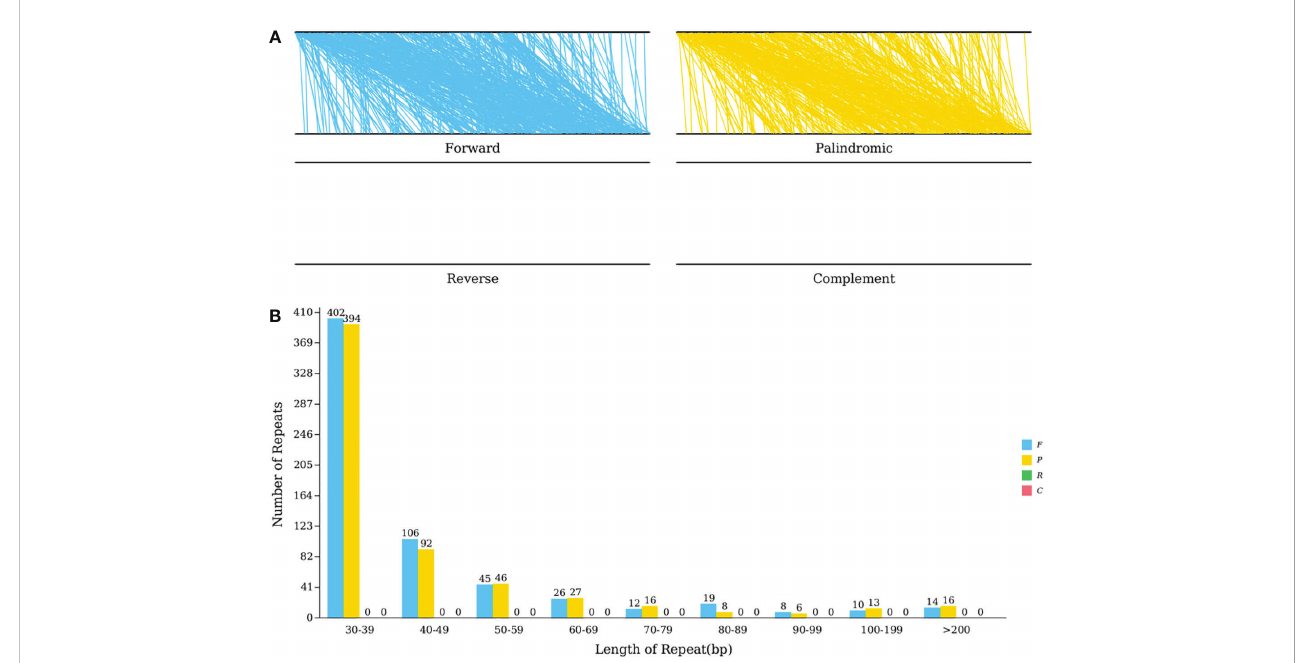
FIGURE 6 C .duntsa mitochondrial repeats. (A) The mitochondrial genome and its forward copy both contain forward repeats.Palindromic repeats in mitochondrial genome and its reverse complement. (B) C.duntsa mitochondrial genome repeat length distribution. Histograms display the repeat number of given